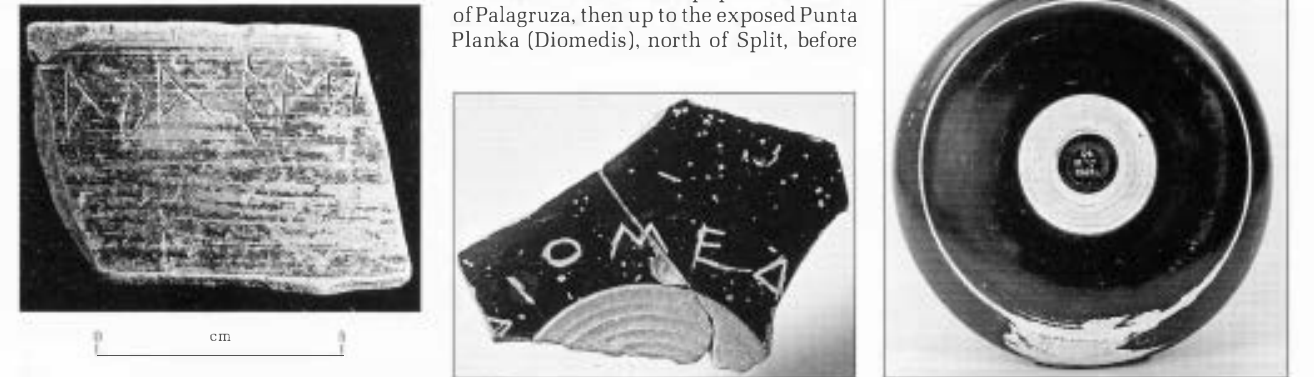
Figure 6 Graffito in Boeotian script on a local drinking cup from Kommos, seventh Figure 7 Inscribed fragment (left) of a phi ale (libation bowl) found on Palagruza, pre­ century BC; this is an owner's inscription; serving most of the name of the recipient, Diomedes; it very closely resembles a phi ale from a tomb of c. 500 BCatKamiros on Rhodes (right, diameter 1 7.7cm}, British Museum similar scraps of text found may be dedi­ cations and one is an alphabet row. (number